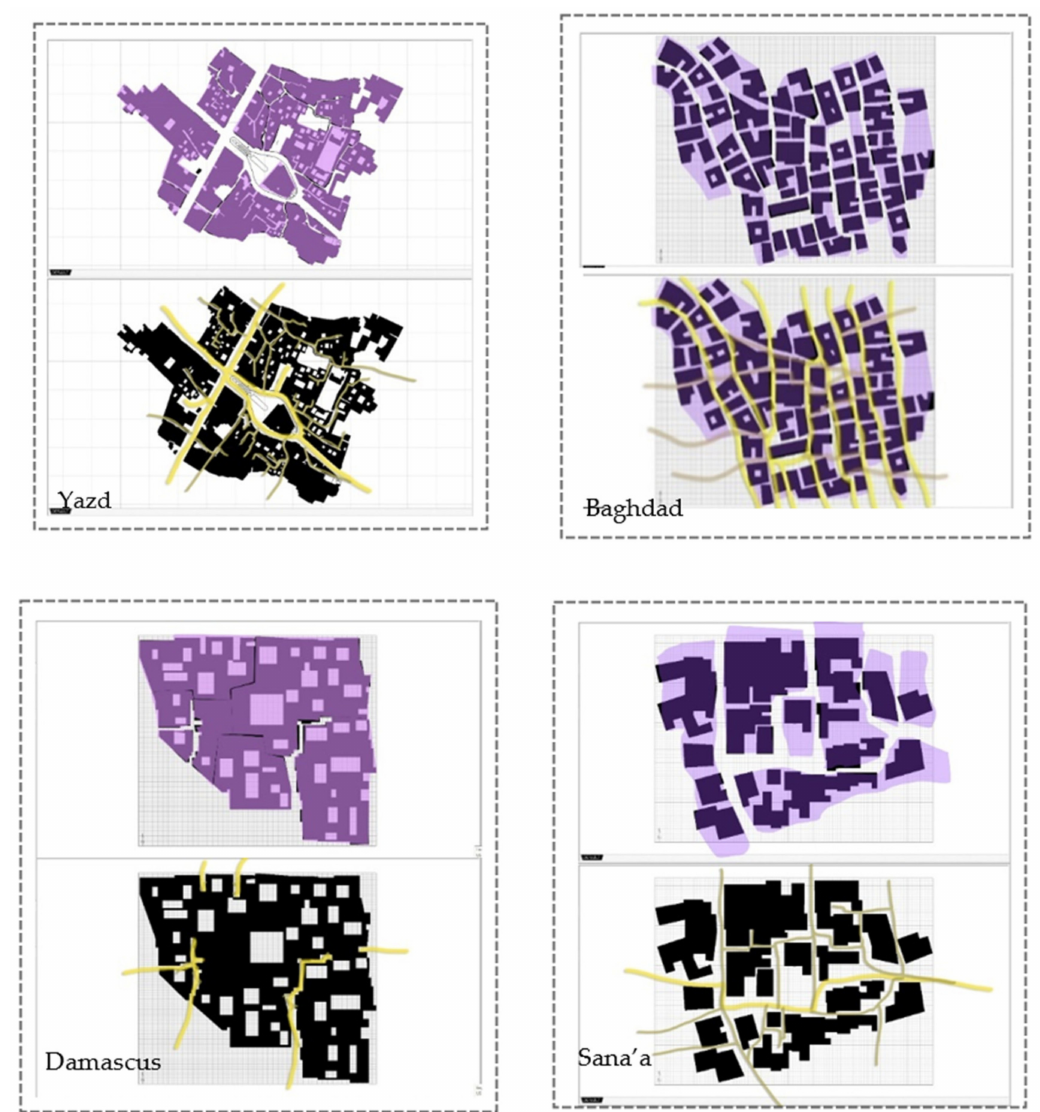
Figure 6. Structural unity, components, shape, and layout of the traditional urban fabric for study cities in West